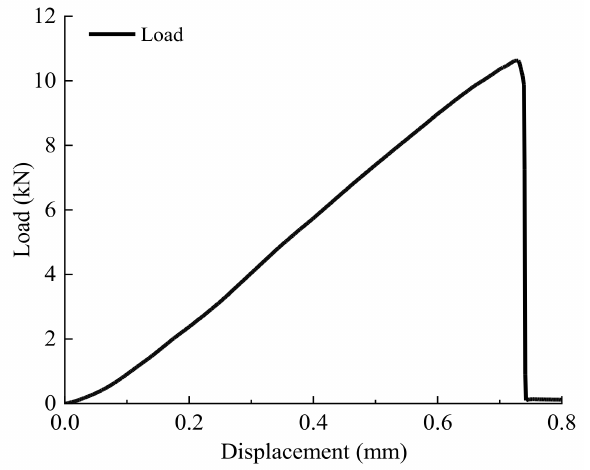
Figure 7. Load–displacement